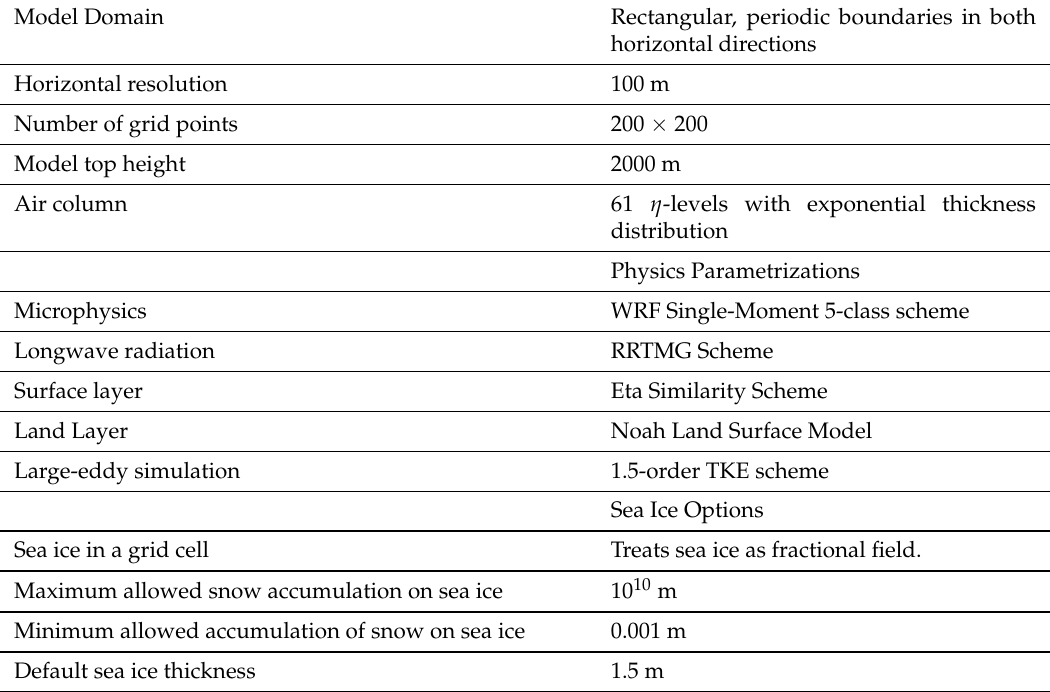
Table A1. WRF model configuration used in the analysis described in the present